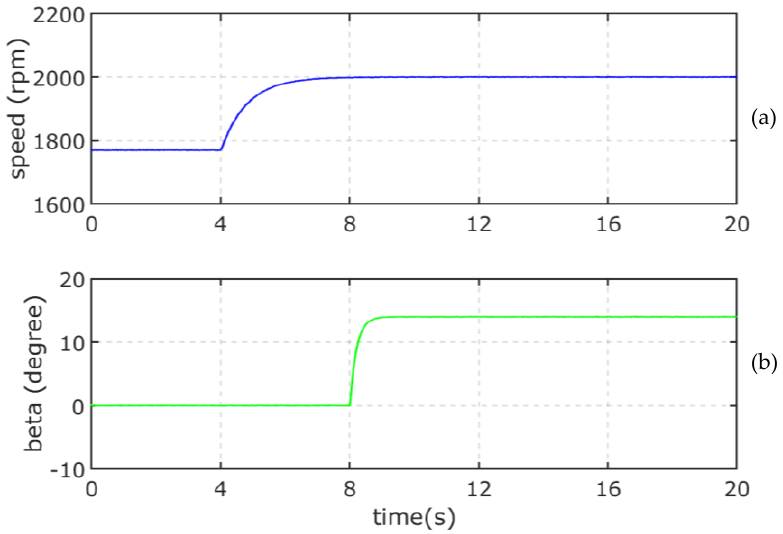
Figure 12. Operation at constant load and variable wind speed [( a ) rotational speed; ( b ) pitch angle].